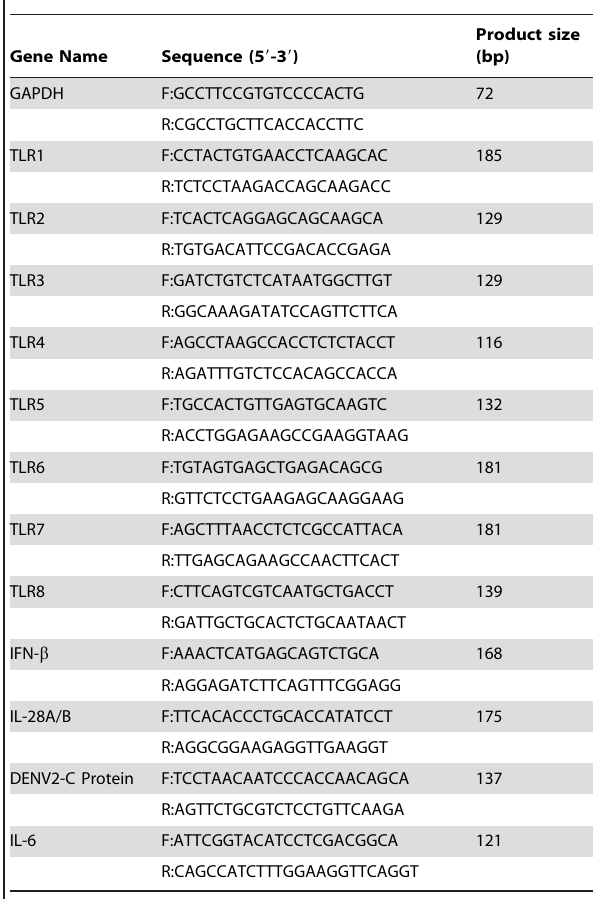
Table 1. Primers for